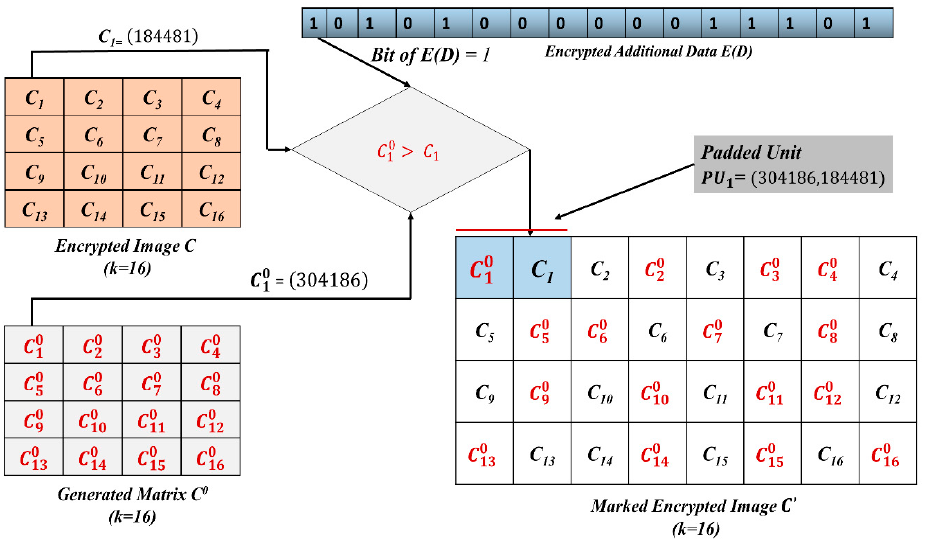
Figure 6. Data embedding process in our proposed scheme after getting an encrypted image C of size ( 4 × 4 ) from the content-owner. C 0 and C 1 are the values for index k = 1 of C 0 and C , 1 respectively.